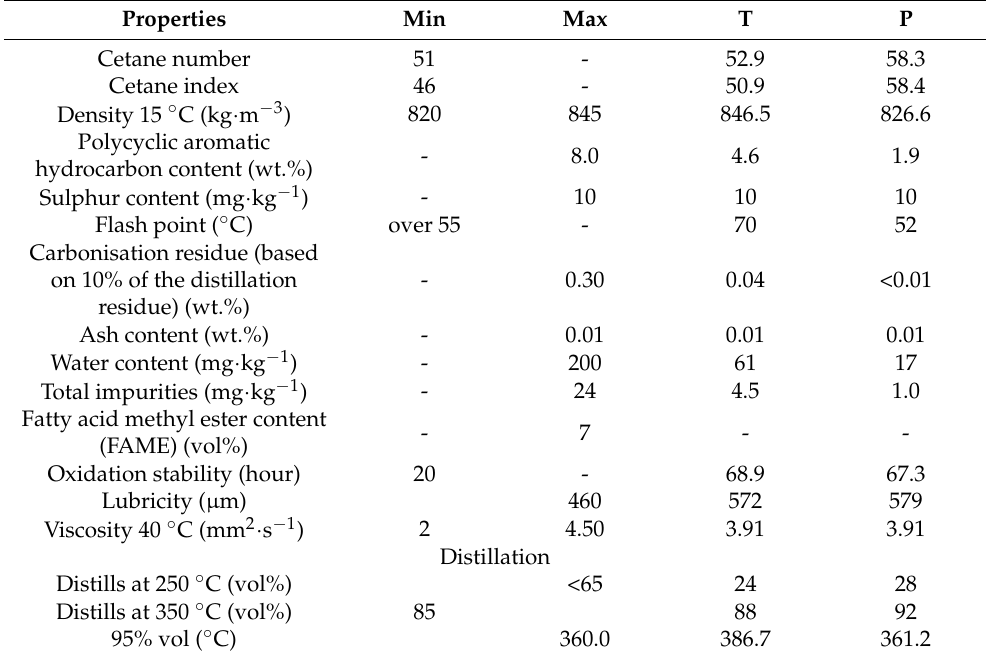
Table 8. Comparison of product values with EN